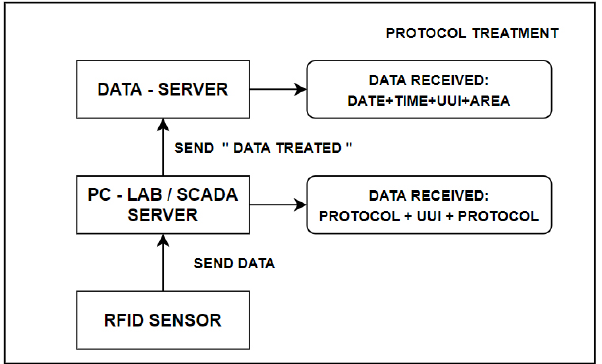
Figure 13. Block-Production: Experimental Implementation at University of Evora: 1 = SCADA server PC where the SCADA application runs, 2 = RFID Read/write Sensor and Antenna (SICK RFU620-10100), 3 = PLC - Programmable Logic Controller (SIEMENS Simatic S7-1200), 4 = HMI - Human Machine Interface (HMI SIEMENS Simatic KTP600).